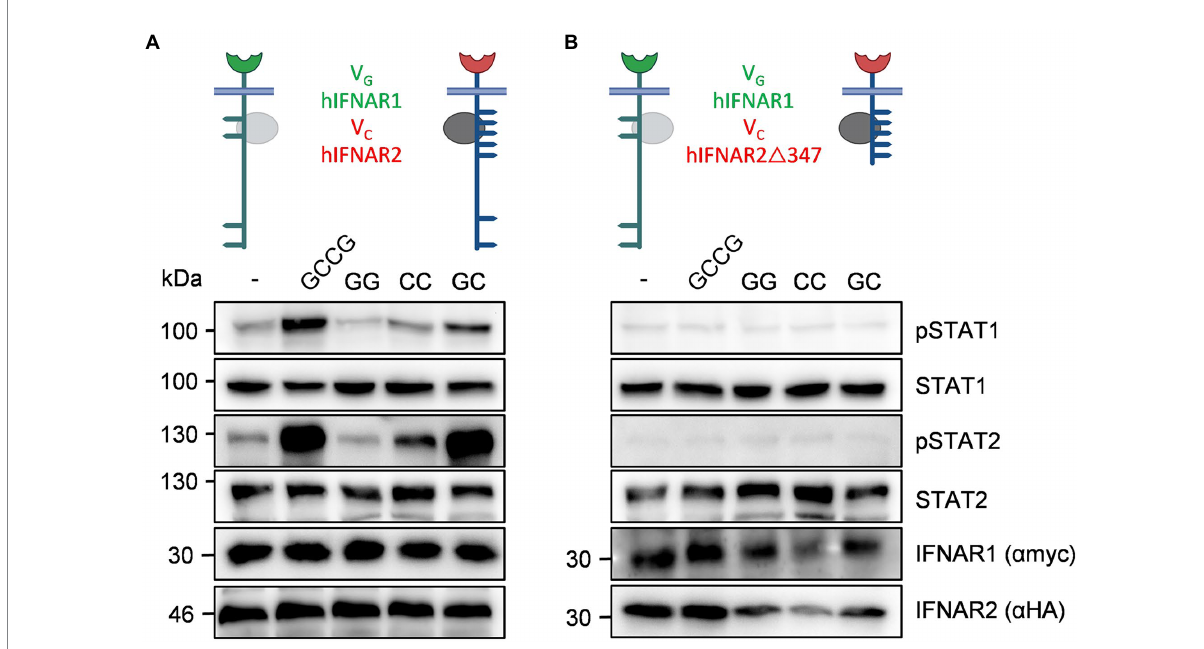
FIGURE 8 Human IFNAR2 is critical for STAT1 and STAT2 phosphorylation. The following human receptor combinations were transiently transfected into HEK293 cells: (A) V G IFNAR1 and V C IFNAR2 and (B) V G IFNAR1 and V C IFNAR2 Δ 347. (A,B) STAT1 and STAT2 activation was determined in transiently transfected HEK293 cells treated with 10 ng/ml Hyper-IL-6, 100 ng/ml of the synthetic cytokine ligands (GCCG, GG, CC, GC) for 30 min.